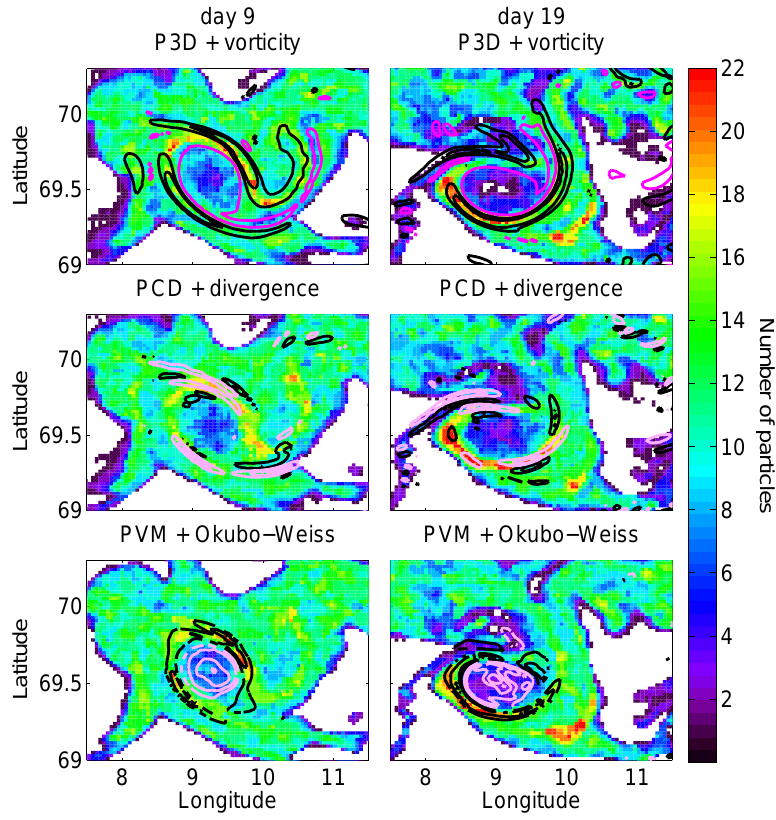
Fig. 4. Depth-integrated particle concentration for each of the surface particle simulations on day 9 (1st column) and day 19 (2nd col- umn) after initialization. The colour show the number of particles within a pixel, white pixels have no particles (the raw fields were filtered with a 3 × 3 median filter to make patterns more visible). Particles at all depth were taken into account and the size of the pixels are 1/48 ◦ × 1/19.2 ◦ . The overall pattern of distribution is similar for all three runs. Super-imposed on the particle concentrations are physical parameters in model layer 5 plotted as contours – black for positive values and pink for negative values: Upper panel – vorticity (contour in- tervals: 2 × 10 − 5 s − 1 ) , middle panel – divergence (contour intervals: 5 × 10 − 6 s − 1 ) , and lower panel – the Okubo-Weiss parameter (contour intervals: 1 × 10 − 9 s − 2 )